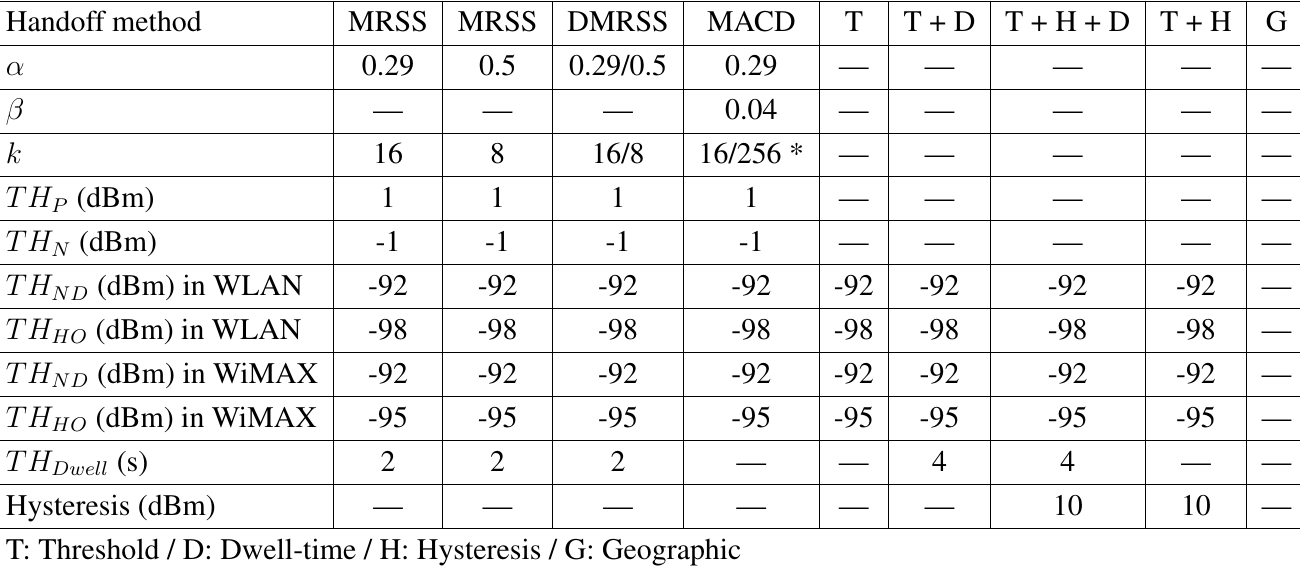
Table 7. Parameters for the evaluation of handoff mechanisms in WLAN and Mobile